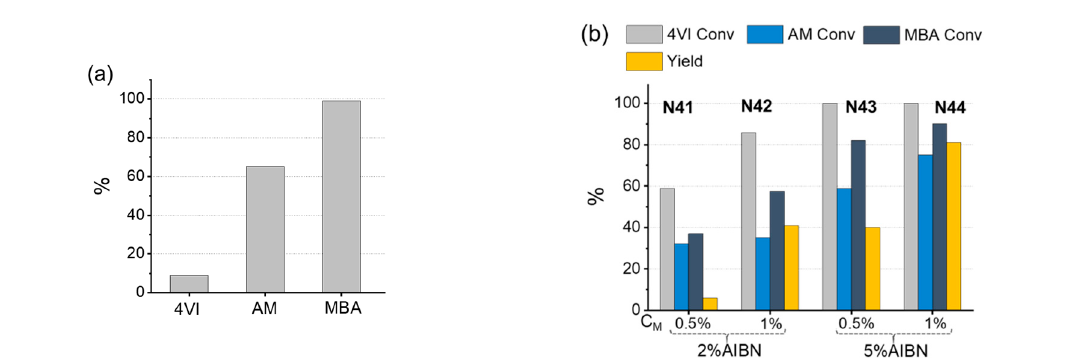
Figure 4. Graphs showing 4VI, AM, and MBA conversions, determined by 1 H NMR analyses, for ( a ) homopolymerizations in DMSO- d 6 (70 °C, 12 h, C M = 1%, AIBN = 1%) and ( b ) copolymerizations in DMSO- d 6 (70 °C, 24 h) at two different C M values and using two different AIBN concentrations ( N41 – N44 ). Feed composition in all copolymerizations: 4VI (10 mol %), AM (40 mol %), and MBA (50 mol %). The yellow bar represents the isolated yield.